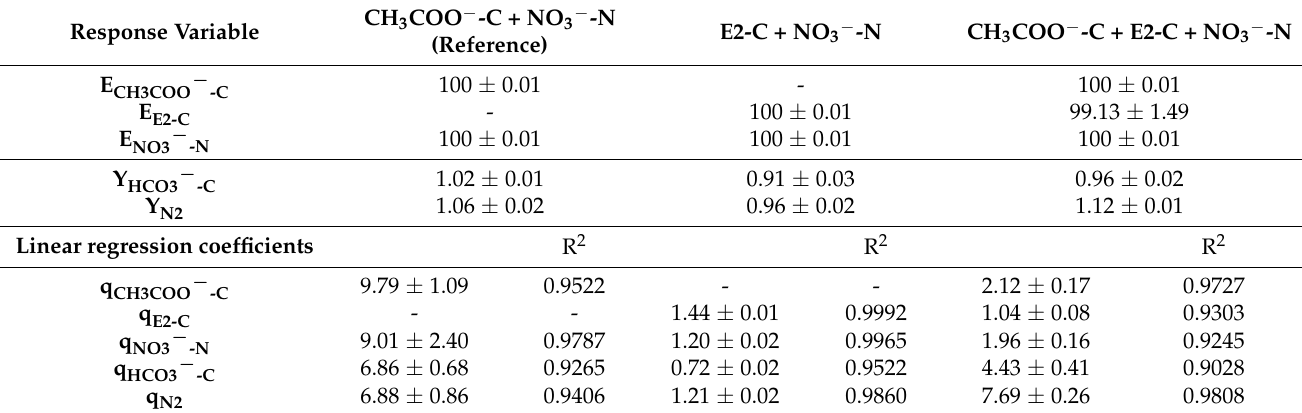
Table 2. Response variables of the reference denitrifying assays, with estradiol (E2) as the only electron source and the assays with a mixture of E2 and CH 3 COO − .